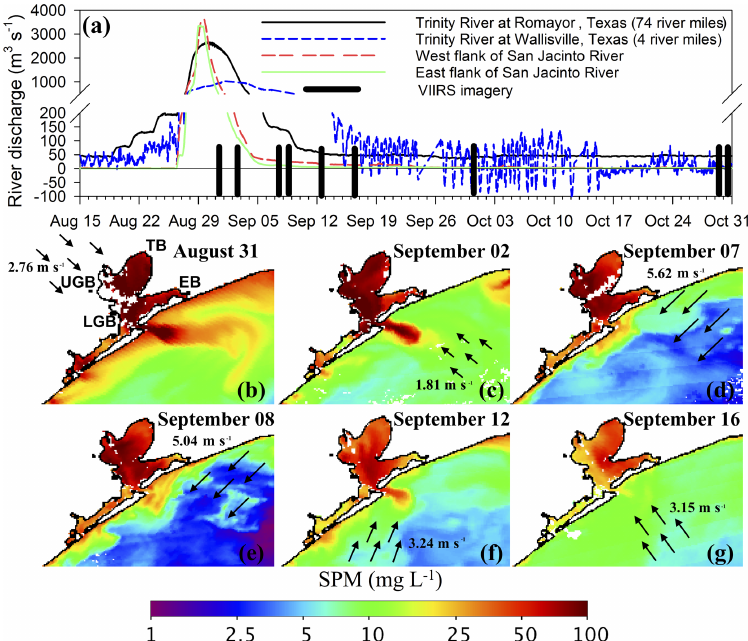
Figure 9. (a) River discharge of the Trinity River at Romayor, Texas (black line) and Wallisville, Texas (blue line); the west flank of the San Jacinto River (red line) and the east flank of the San Jacinto River (green line). The river discharge at the Wallisville site was not corrected for the tides. Black bars represent the days of VIIRS satellite imagery for SPM analysis in Galveston Bay. (b–g) Post-hurricane SPM maps of Galveston Bay. TB: Trinity Bay, UGB: upper Galveston Bay, LGB: lower Galveston Bay, EB: East Bay (Fig.